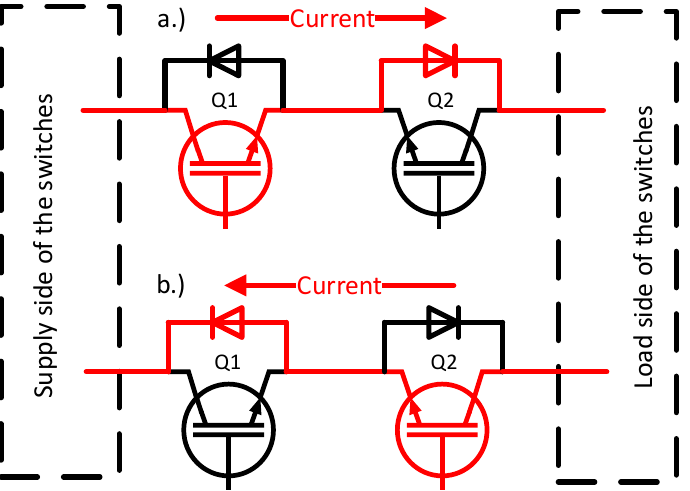
Figure 1. Current flow in IGBT-based bidirectional switch ( a ) Positive current flow, ( b ) Negative current flow.